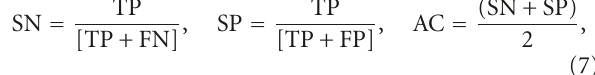
algorithmic complexity of the whole program is O ( TND ∗ ) where N = 54 sub-states and D ∗ is the number of bins for